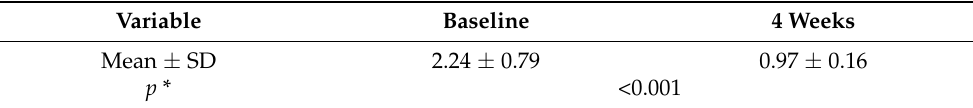
Figure 3. Gingival depigmentation at 12-week follow-up. ( a ) Before treatment—DOPI score 3; ( b ) 1 week treatment—DOPI score 1; ( c ) 4 weeks treatment—DOPI score 1; ( d ) 12 weeks treatment— DOPI score 1. Table 5. Pre- and 4-week postoperative comparison of DOPI